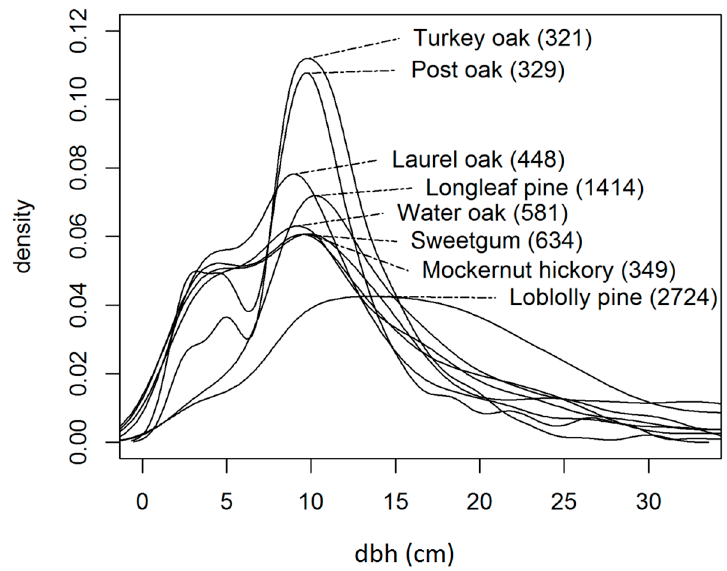
Figure 2. Dbh densities (relative frequency) for the 8 most common species (common names and numbers of trees) measured on fixed radius plots. Table 1. Summary statistics for plot measurements.